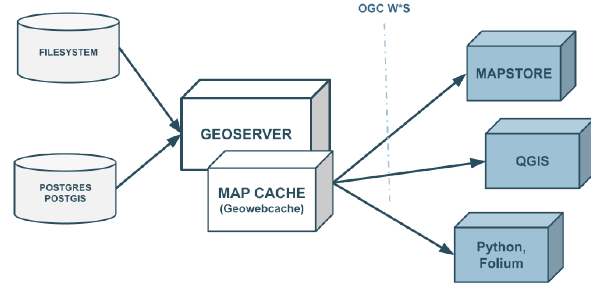
Figure 6. eMOTIONAL Cities Legacy stack